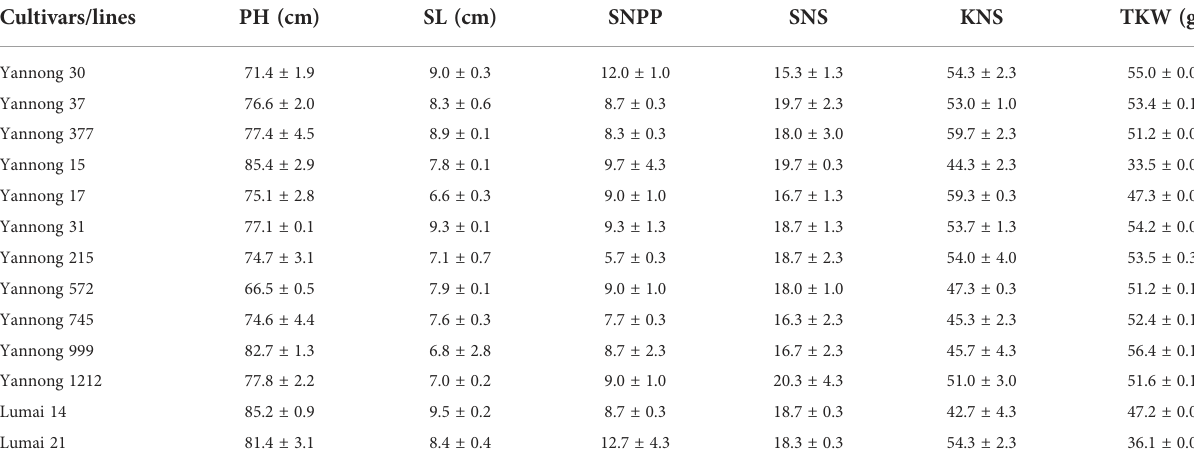
TABLE 1 Agronomic traits evaluation of 13 Yannong cultivars/lines.